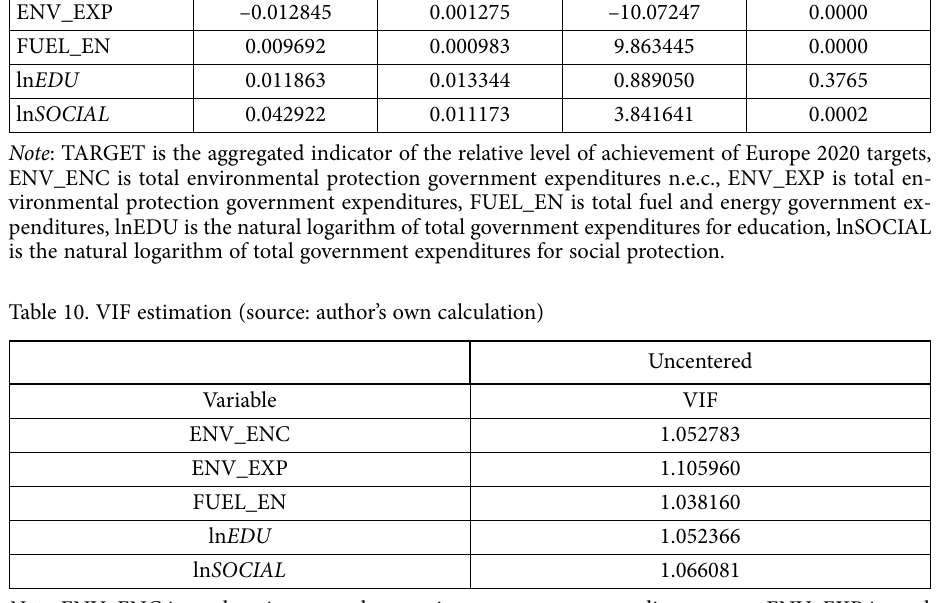
Table 9. FMOLS estimation (source: author’s own calculation) Variable Coeff. Std. Error t-Stat. Prob. ENV_ENC 0.012772 0.004286